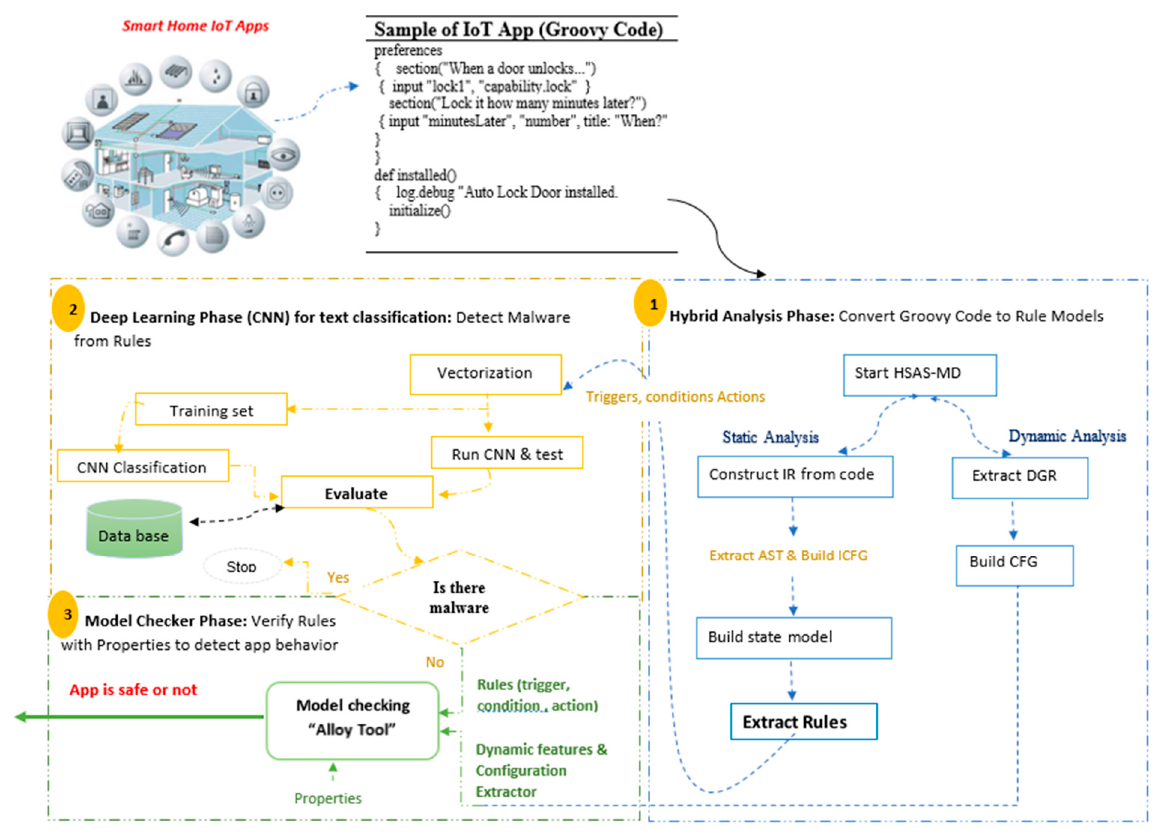
Figure 5. HSAS-MD analyzer phases.